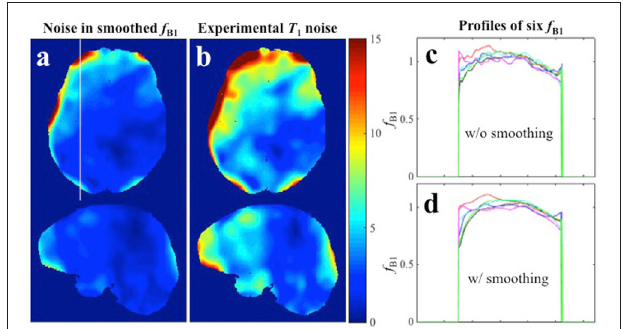
FIGURE 6 | Spatial smoothing effects in Experiment 1 with small spoiler gradients. (a) CV map of the six f B 1 after smoothing. (b) CV map of the six T 1 maps estimated with the six smoothed f B 1 ( Experimental variance evaluation ). (c,d) Profiles along the white line in (a) for the six original f B 1 maps and six smoothed f B 1 maps